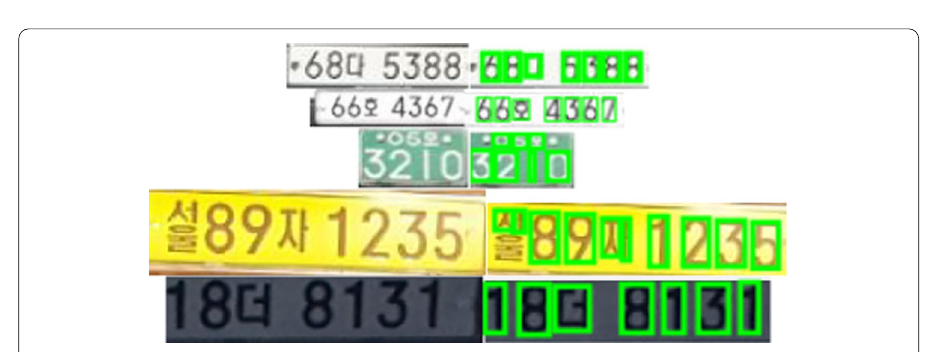
Fig. 7 Character